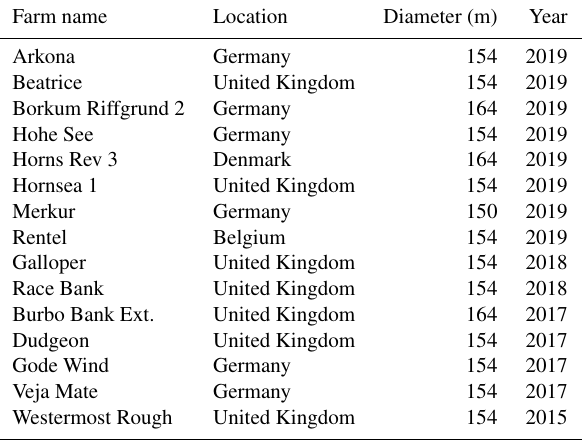
Table 1. List of offshore wind farms with commissioned wind tur- bines having a rotor diameter larger than